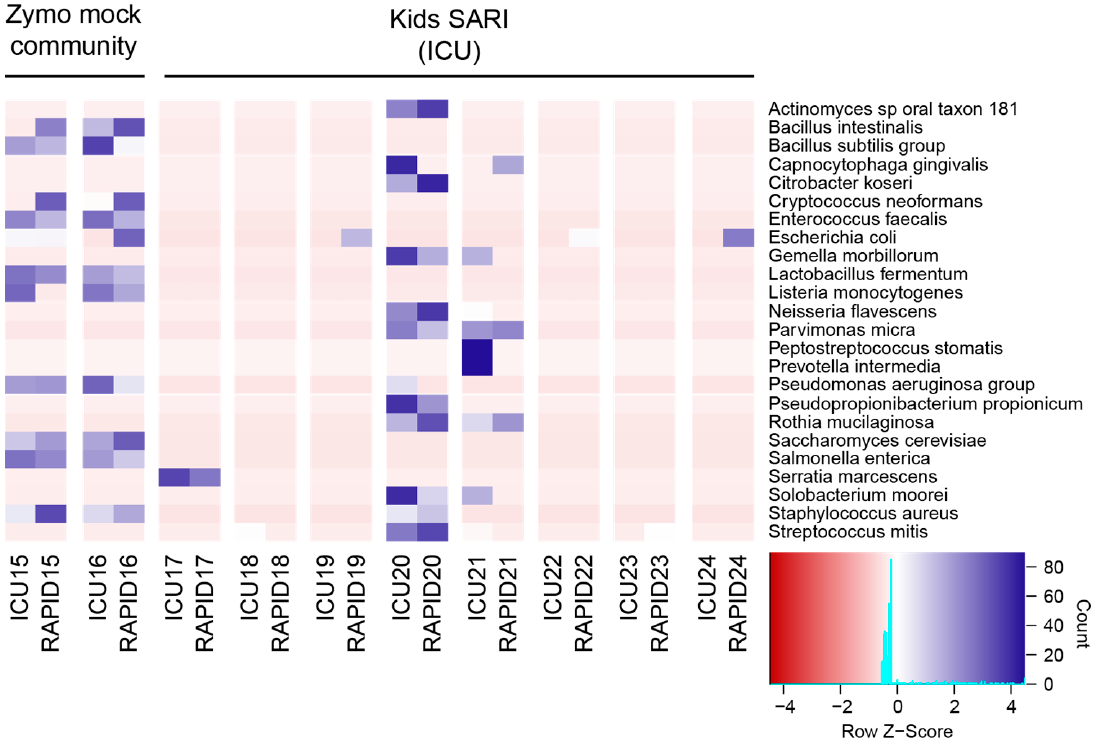
Figure 4. Comparison of RAPID prep to commercial RNA library preparation kit. Using previously generated data for the kids SARI cohort, we compared the 24 most abundant species identi fi ed across both protocols for the same set of samples. An unclustered heatmap of microbial abundance (Z-score) is shown, with di ff erences between samples identi fi ed by a deeper blue shading, while organisms conserved across samples are lighter blue through to red. A frequency histogram is over- layed on the color key and signi fi es the count of each Z score at any given point. Tick labels on the X-axis in the ICUXX format represent deep-RNA sequencing generated previously, while tick labels in the RAPIDXX format represent sequencing data generated in this study using the RAPID prep assay for the corresponding samples.